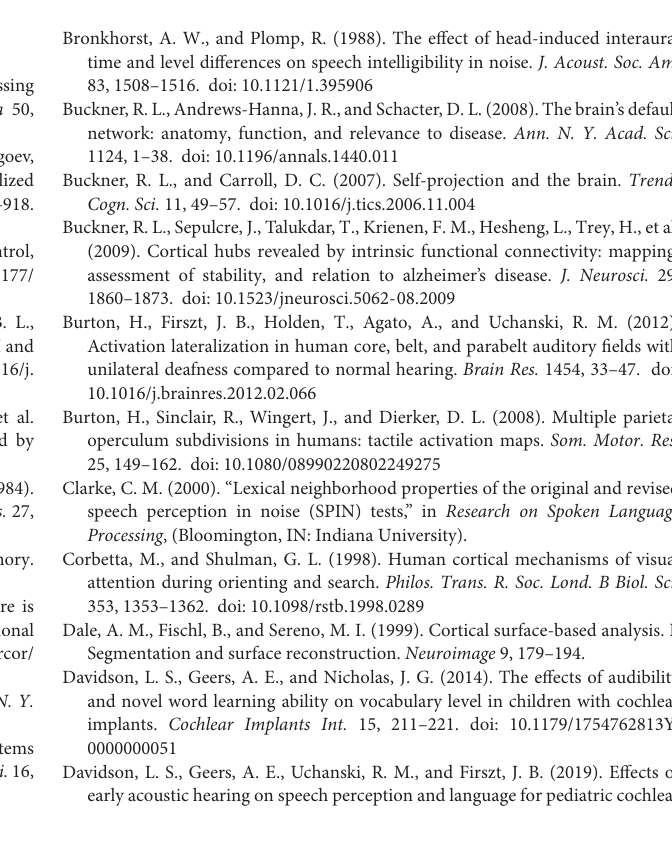
Supplementary Figure 1 | Sample interrupted imaging sequence shows 5 trials with 9 s frame repetitions (TR). Each TR starts with a 2 s volume acquisition (TA) followed by a 7 s interval of silence with no pulse sequence noise. Tan and red colored rectangles during scanner silence mark, respectively, presentations of low and high predictability (LP or HP) sentences. The midpoint of each sentence duration, averaging 1.78 s, occurred at the 2 s middle of the sentence presentation rectangles, which aligned 5 s prior to the midpoint of each subsequent TA. Vertical tick marks below the pulse sequence are in 1 s intervals. Supplementary Figure 2 | Bar graphs show mean and SEM of percent signal change averaged across all vertices per named parcel in RH cortex. Supplementary Figure 3 | Bar graphs show mean and SEM of percent signal change averaged across all vertices in matched named parcels in LH and RH. Black brackets mark LH vs. RH significant response amplitude differences of all p values <